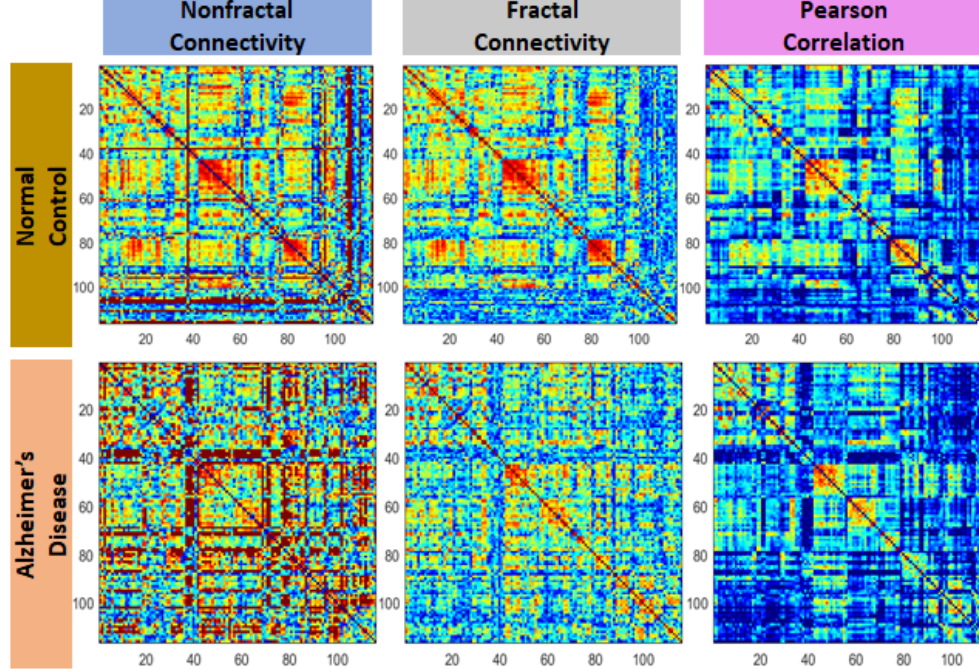
Figure 4. Samples of nonfractal, fractal and Pearson connectivity matrices from normal control (NC) and an Alzheimer’s disease (AD) subject extracted using the AAL-based BOLD time series